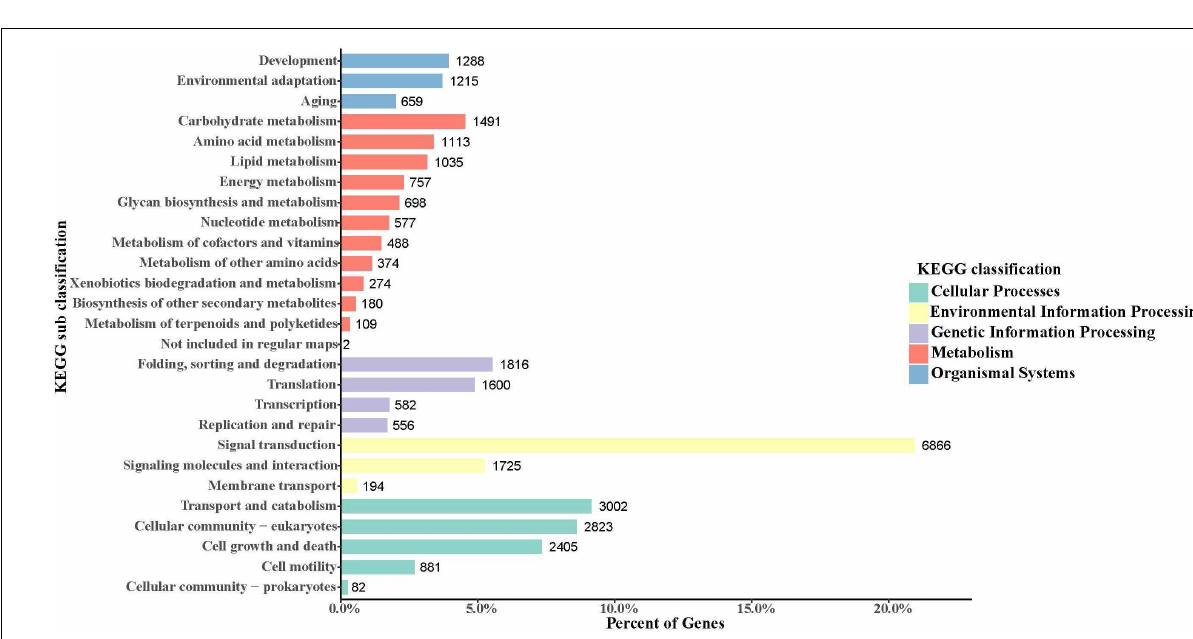
FIGURE 3 | Annotation of unigenes of S. caldwelli in the KEGG pathway database. From top to bottom by color: organismal systems, blue; metabolism, red; genetic information processing, purple; environmental information processing, yellow; cellular processes, green.